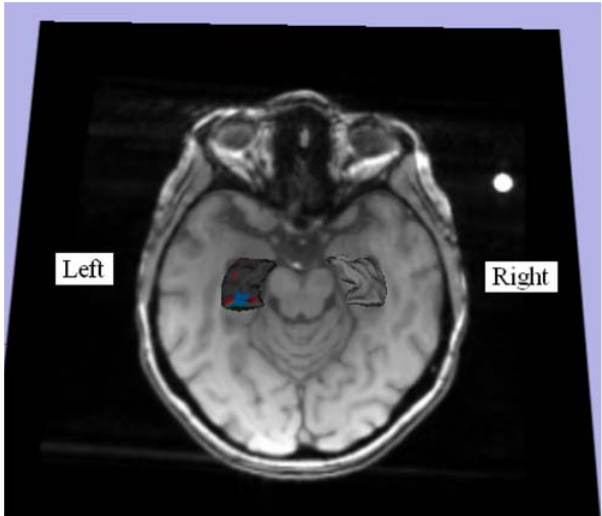
Figure 2. The analysis of hippocampus: control vs. depressed. The distance maps masked by the significance maps are shown on a pair of representative hippocampi. The scale of color code is illustrated in a color bar and in